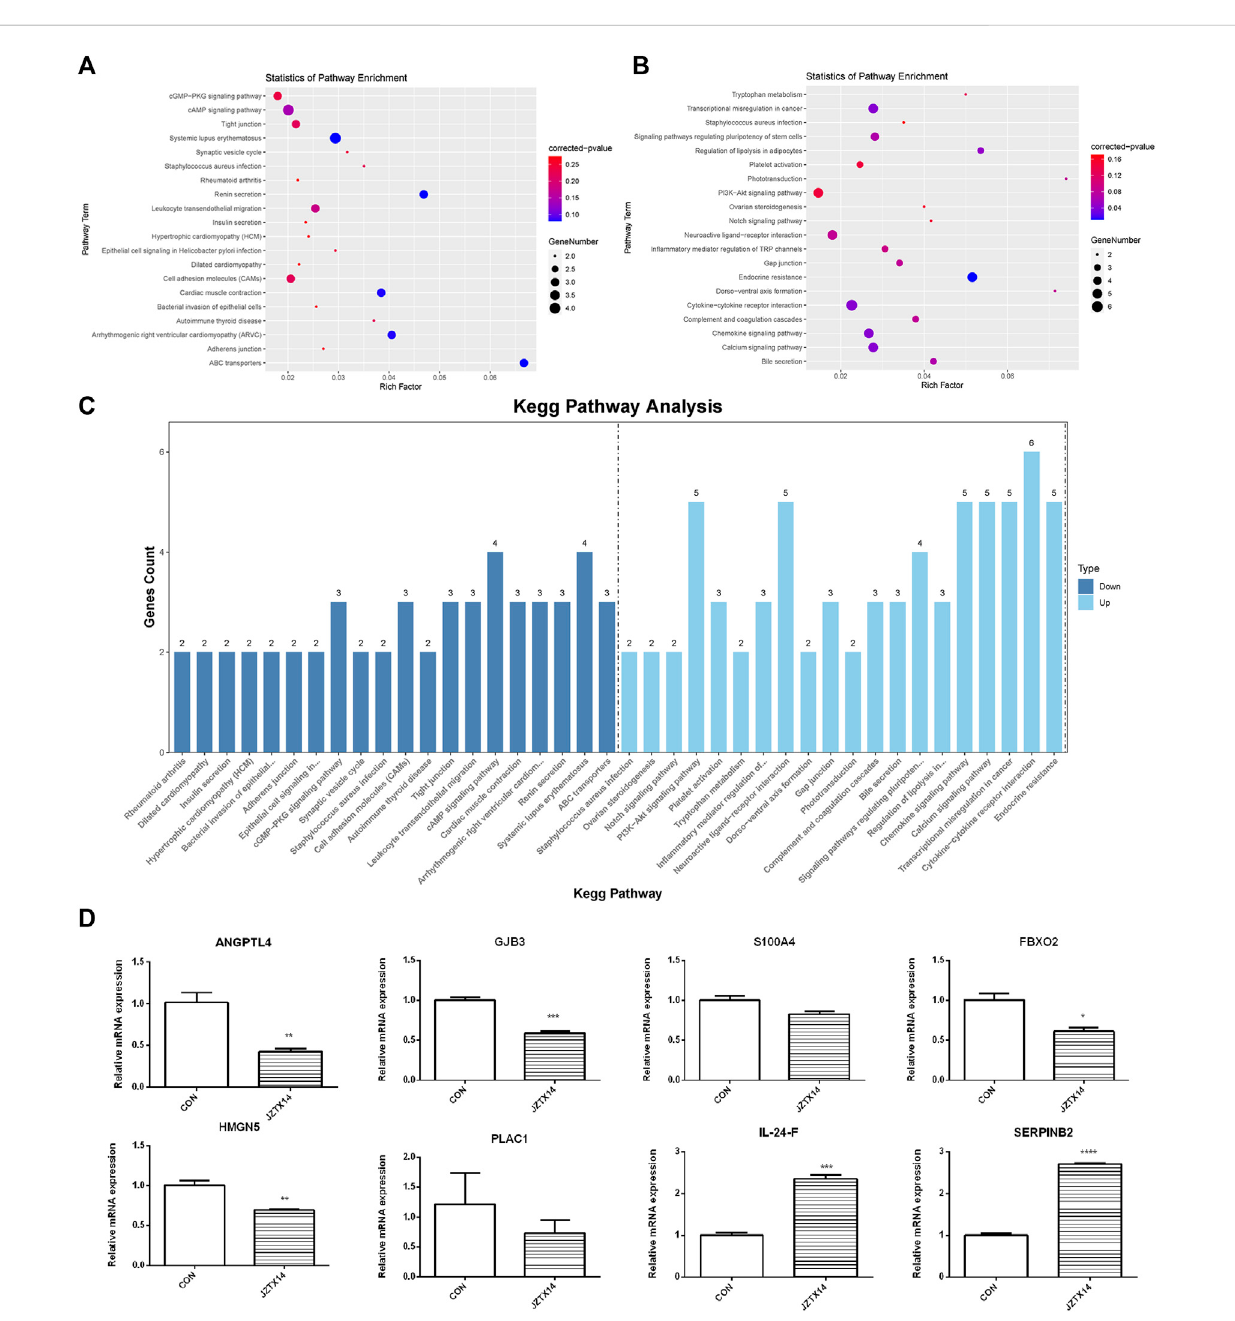
FIGURE 7 Results of KEGG pathway enrichment analysis and qPCR validation of migration-associated differential genes. (A) The top 20 signi fi cantly downregulated KEGG pathways in JZTX-14 -treated MDA-MB-231 cells. (B) The top 20 signi fi cantly upregulated KEGG pathways in JZTX-14 -treated MDA-MB-231cells. (C) Numberofgenesinthetop20pathwayssigni fi cantlyenrichedindownregulatedandupregulatedgenes. (D) Signi fi cantlydifferent migration and invasion-related genes in RNA sequencing results of JZTX-14-treated MDA-MB-231 cells were veri fi ed by qPCR. ANGPTL4, GJB3, S100A4, FBXO2, HMGN5, and PLAC1 were downregulated; IL-24-F and SERPINB2 were upregulated.